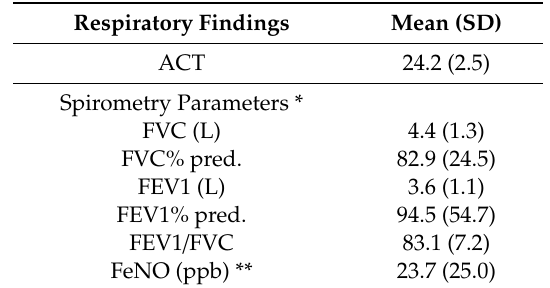
Table 3. Main lower respiratory